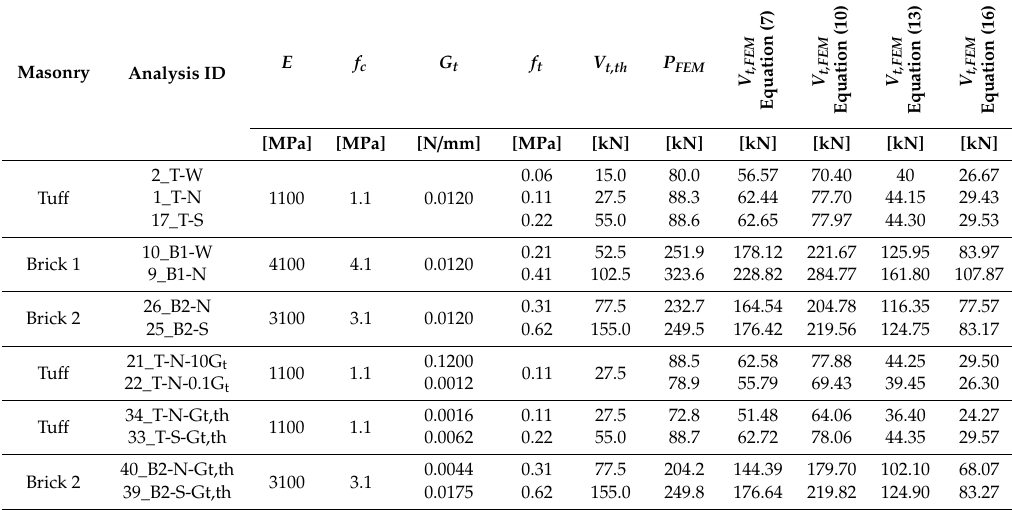
Table 1. Theoretical and numerical results for the un-strengthened panels for di ff erent mechanical properties of